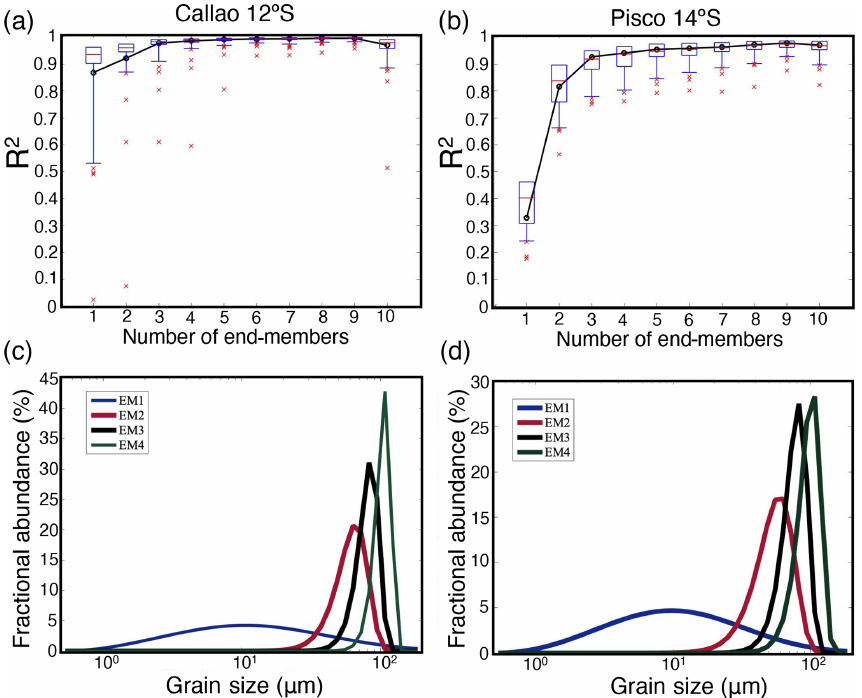
Figure 4. Coefficient of determination ( r 2 ) as a function of the number of end-members chosen to model the observed grain-size distribution in Callao (a) and Pisco (b) . Grain-size distribution of the four end-members in Callao (c) and Pisco (d)